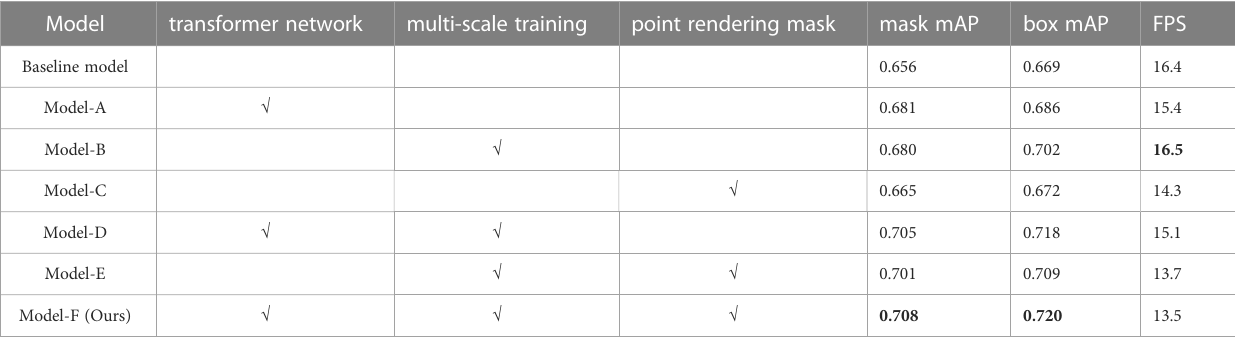
TABLE 3 Ablation study on the pumpkin fruit and stem instance segmentation method.